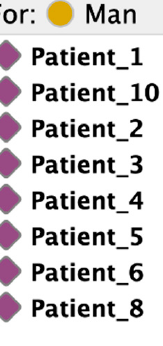
( e ) Figure 5. Representation of patient information : ( a ) Individuals of the class Man ; ( b ) Individual of the class Person_Deceased ;( c ) District of Patient_2 ; ( d ) Individuals of the class Patient_Asymptomatic ; ( e ) District of Patient_3 .